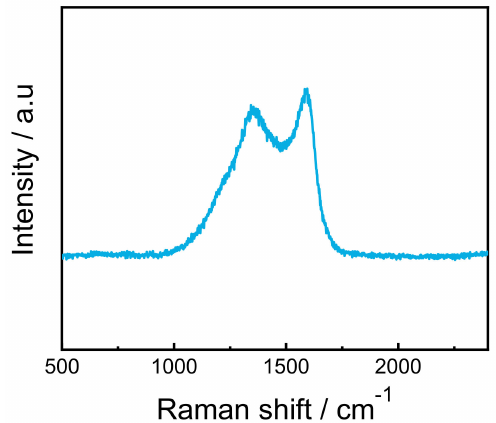
Figure 3. Raman spectra of Fe-BC-900.